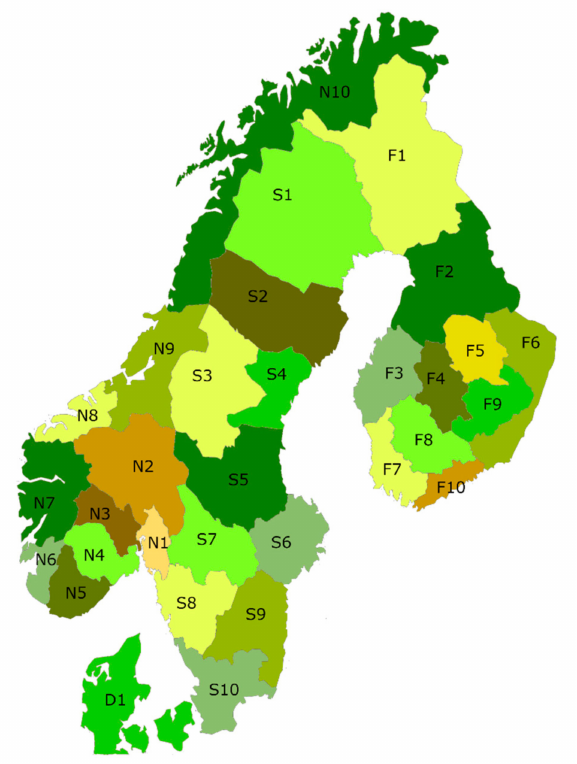
Figure 4. Regions in the Nordic forest sector model (N = Norway, S = Sweden, F = Finland, D =